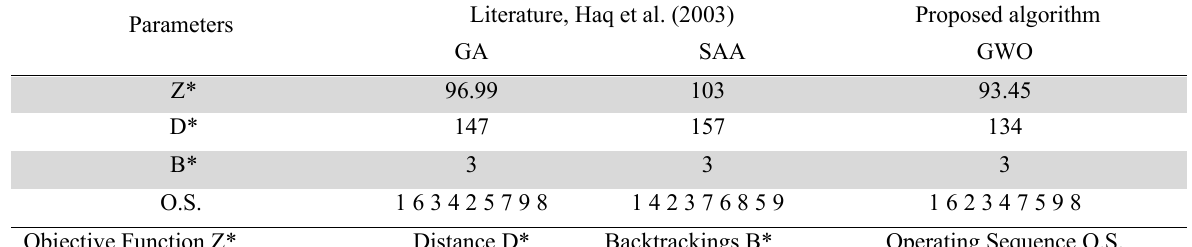
Comparison of objective functions yields from the proposed algorithm and algorithm from literature Parameters